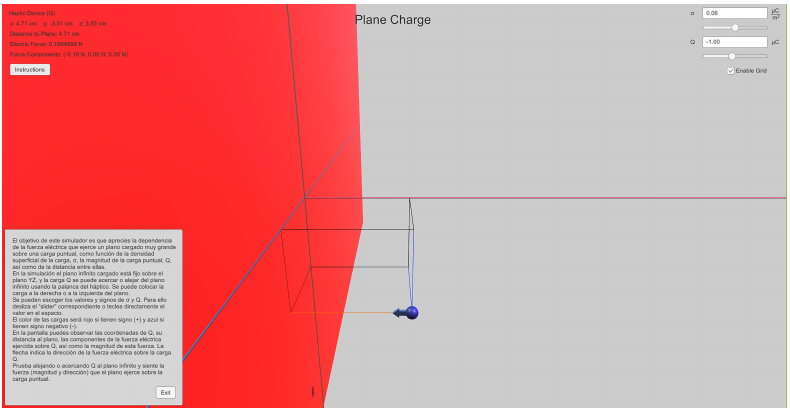
Figure 12. Interface elements of the plane charge visuo-haptic environment developed with VIS- HAPT and HaDIU